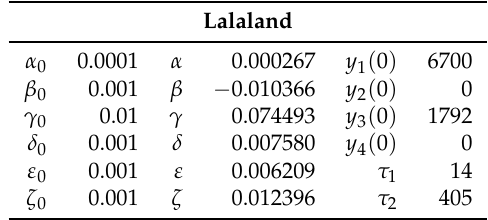
Table 1. Various parameter values.